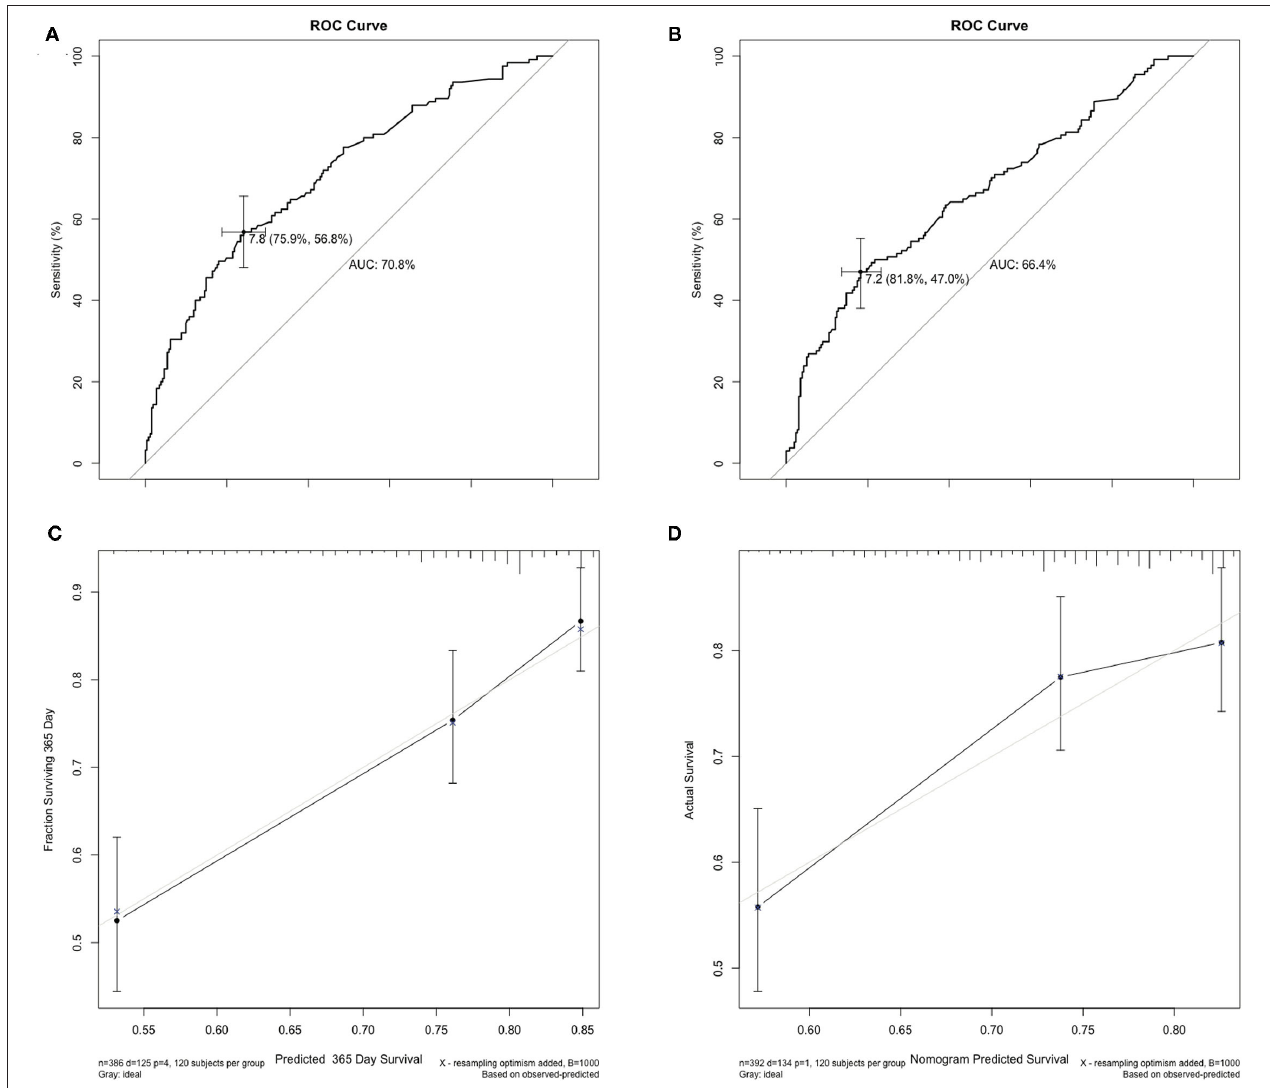
FIGURE 2 | Internal and external validation of the AUC and the calibration curves for predicting the 1-year graft survival. (A) In the training cohort, the AUC for the established nomogram to predict graft survival was 0.708. (B) In the validation cohort, the AUC was 0.660. (C,D) The calibration curves for predicting incidence of 1-year graft survival rate following liver transplantation in the training and validation cohort. AUC, area under the receiver operating characteristic curve.